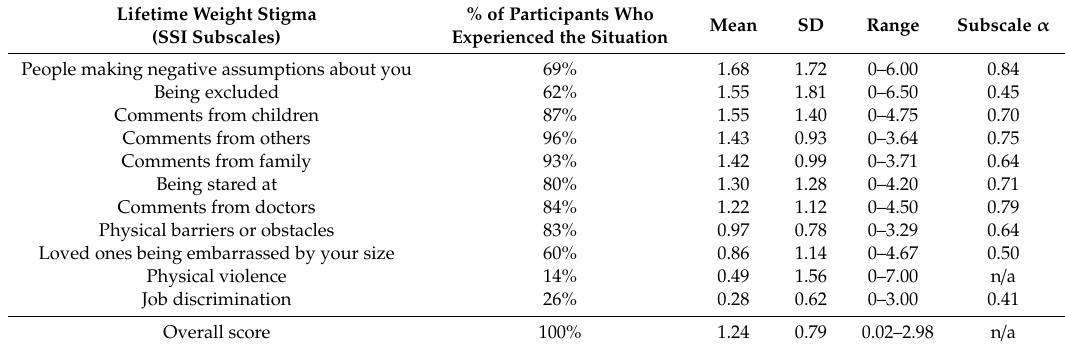
Table 3. Lifetime weight stigma as measured by the Stigmatizing Situations